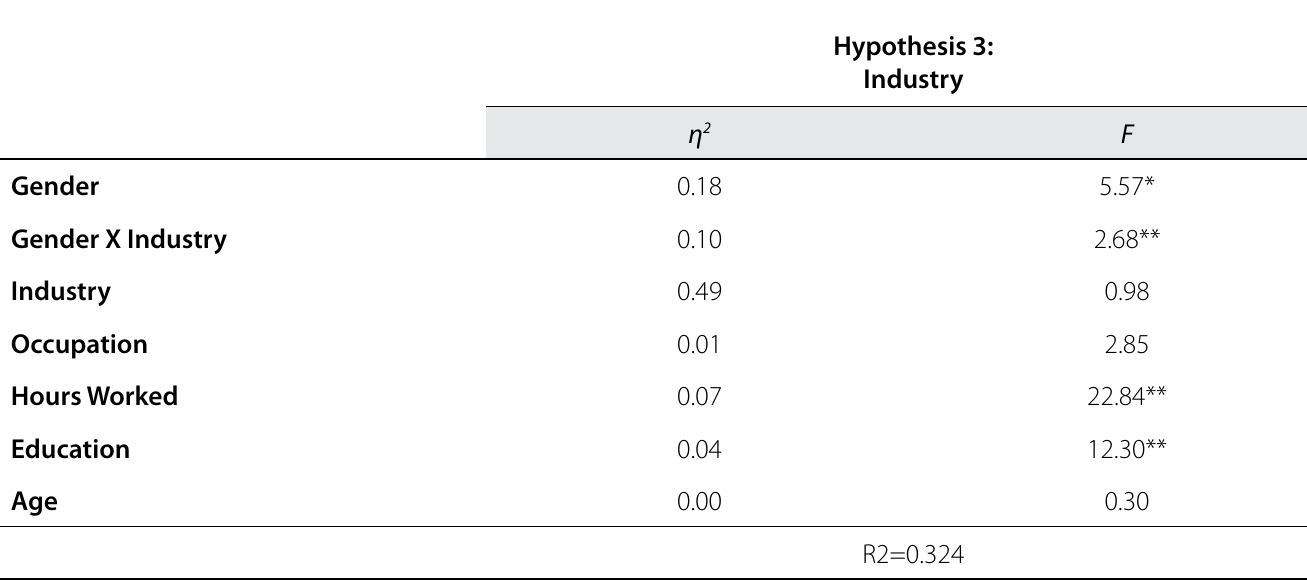
Table 4a.GLM Analysis of Earning Differences by Gender and